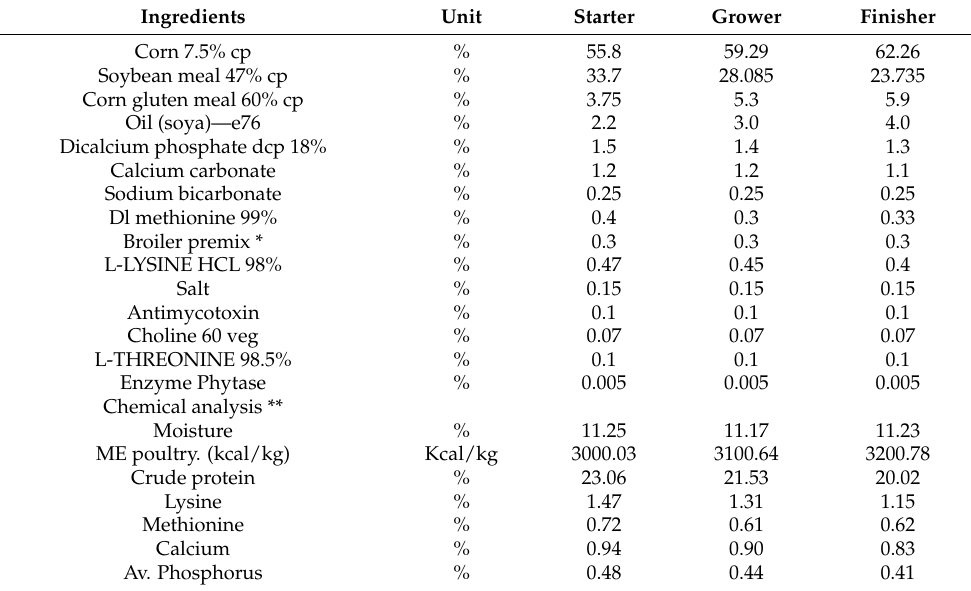
Table 1. The proximate chemical composition of the basal diet as fed basis (%).